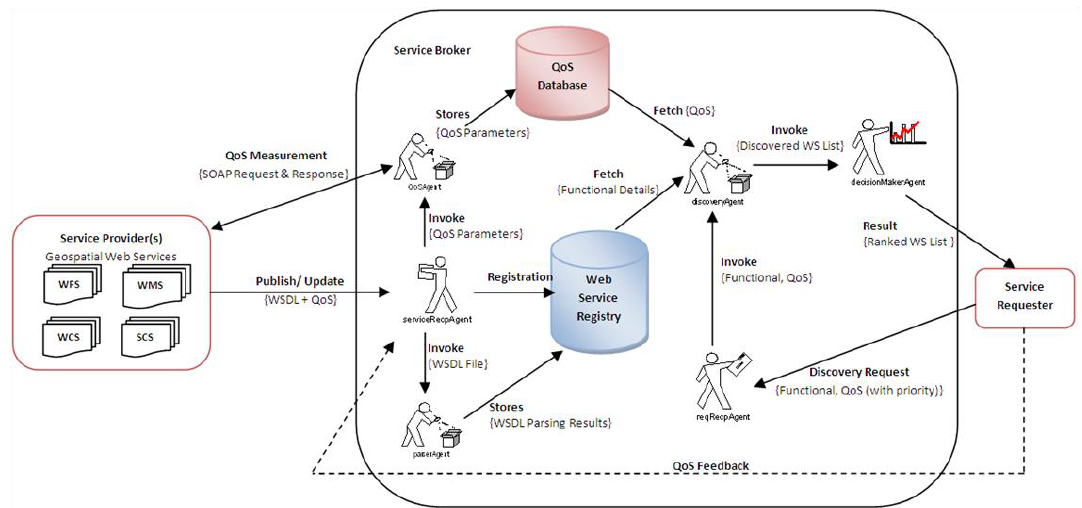
Figure 2. Automated End-to-End Multi-Agent QoS based